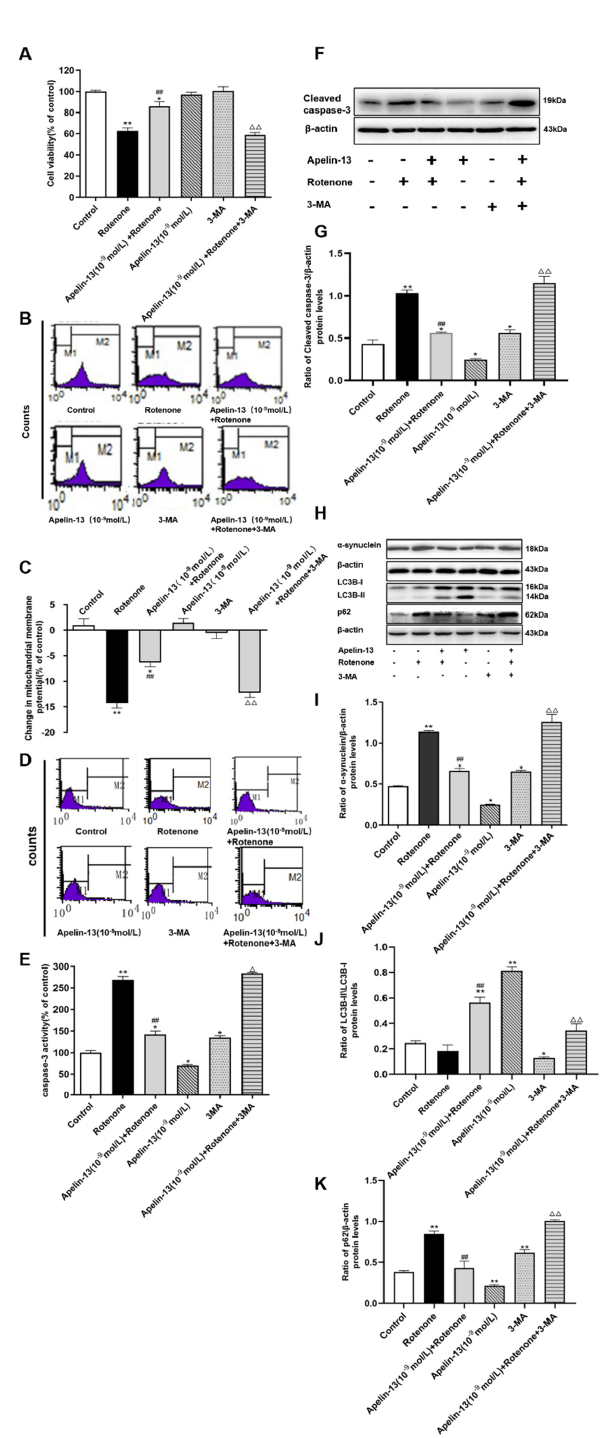
Figure 5. Effects of 3-MA on the neuroprotective effects of apelin-13 in SH-SY5Y cells. SH-SY5Y cells were exposed to rotenone with or without apelin-13 pretreatment, or with 3-MA pretreatment prior to rotenone and apelin-13. ( A ) MTT assay indicated that 3-MA had no effects of cell viability. Apelin-13 restored cell viability in rotenone-treated cells, which was blocked by 3-MA. ( B , C ) Fluorometric assays of ∆Ψ m and statistical analysis. Apelin-13 antagonized rotenone-induced reduction in (cid:52) Ψ M, and pre-incubation with 3-MA abolished these changes. ( D , E ) Fluorometric assay of caspase-3 activity and statistical analysis. Apelin-13 could antagonize rotenone-induced caspase-3 activation, and pre-incubation